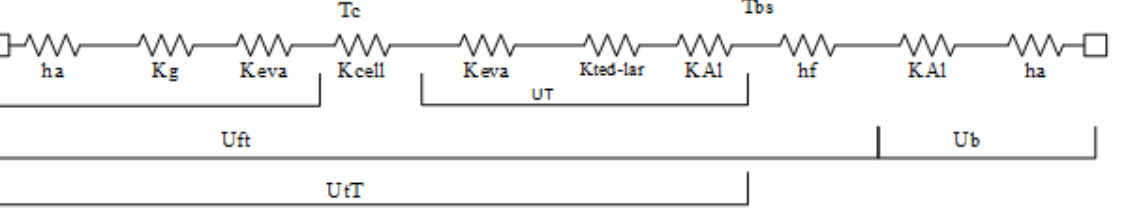
Figure 3. Thermal circuit of a PV/T panel.